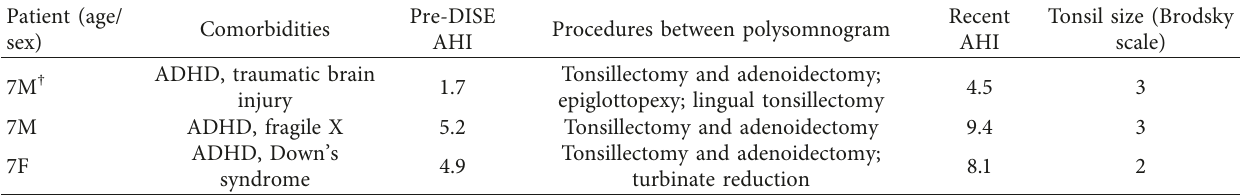
Table 1: Characteristics of pediatric patients with worsened obstructive sleep apnea after tonsillectomy. Patient